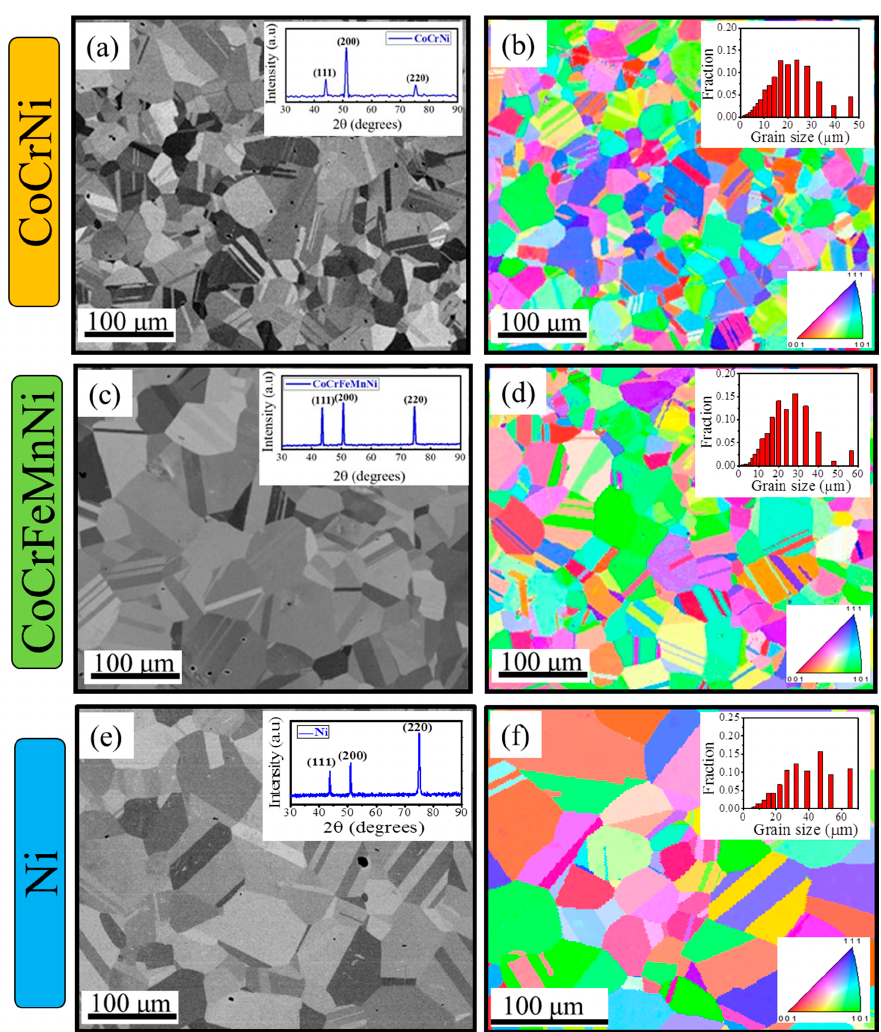
Figure 1. Backscattered SEM images with XRD patterns as insets for ( a ) CoCrNi, ( c ) CoCrFeMnNi, and ( e ) pure Ni. EBSD maps with grain size distribution as insets for ( b ) CoCrNi, ( d ) CoCrFeMnNi, and ( f ) pure Ni.